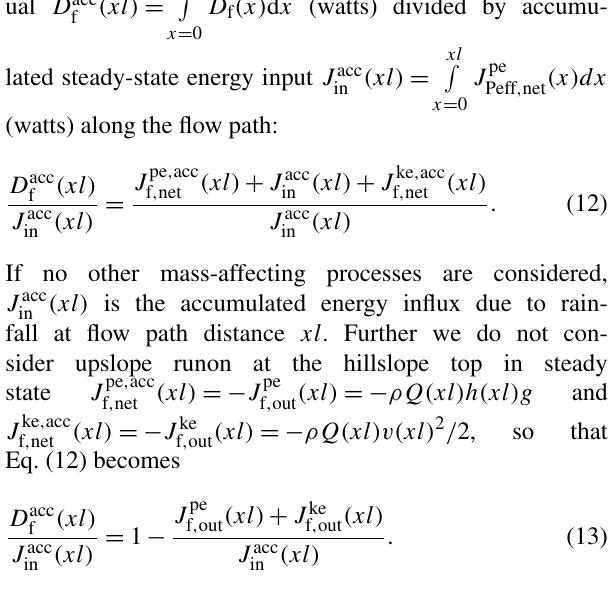
Figure 4. Distribution of potential energy E pe and (c) rainfall intensity I